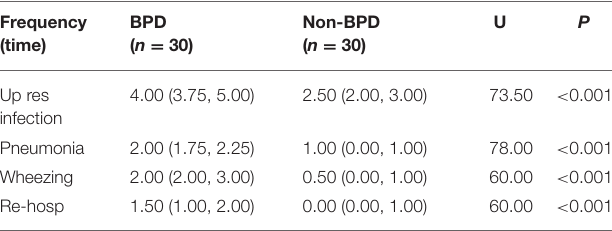
TABLE 2 | Respiratory infections and re-hospitalization in the BPD and non-BPD